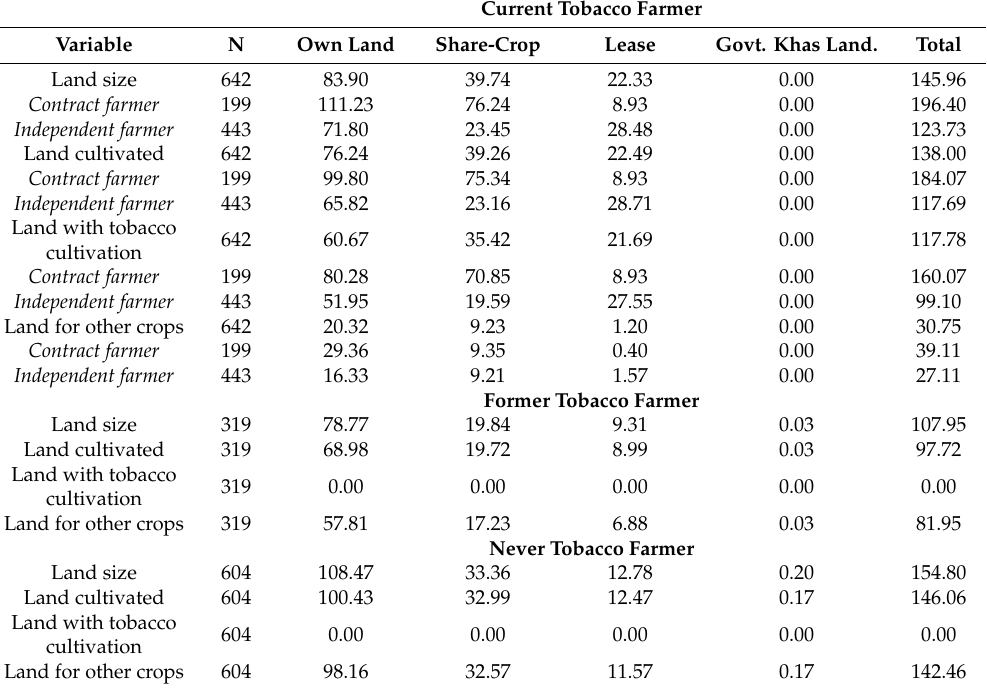
Table 4. Land holding (decimals) of tobacco and never tobacco